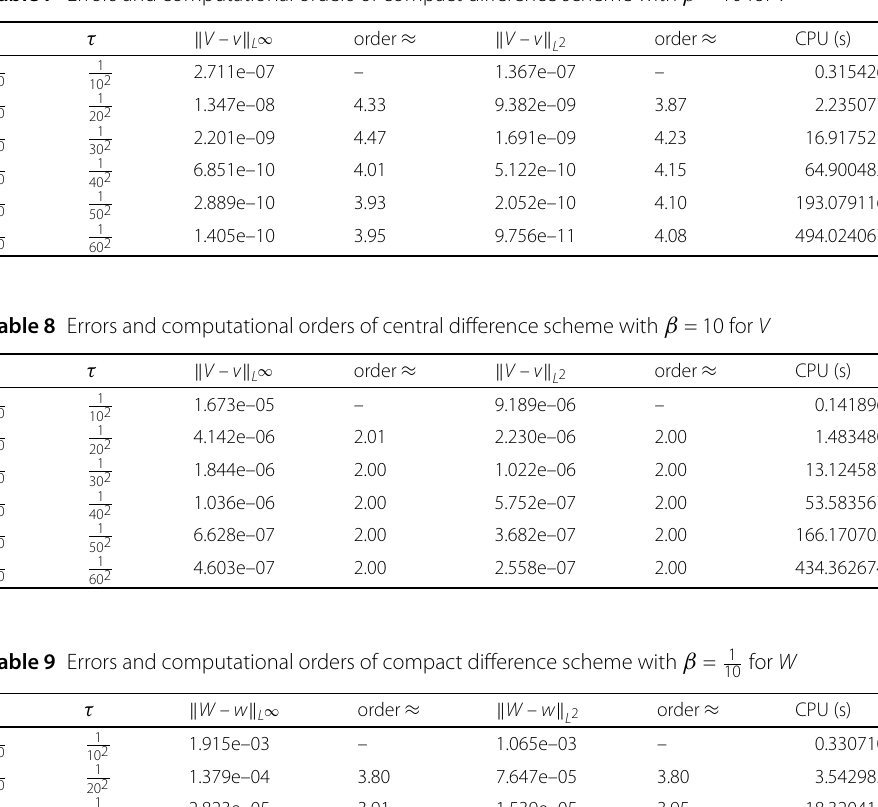
Table 7 Errors and computational orders of compact difference scheme with β = 10 for V h